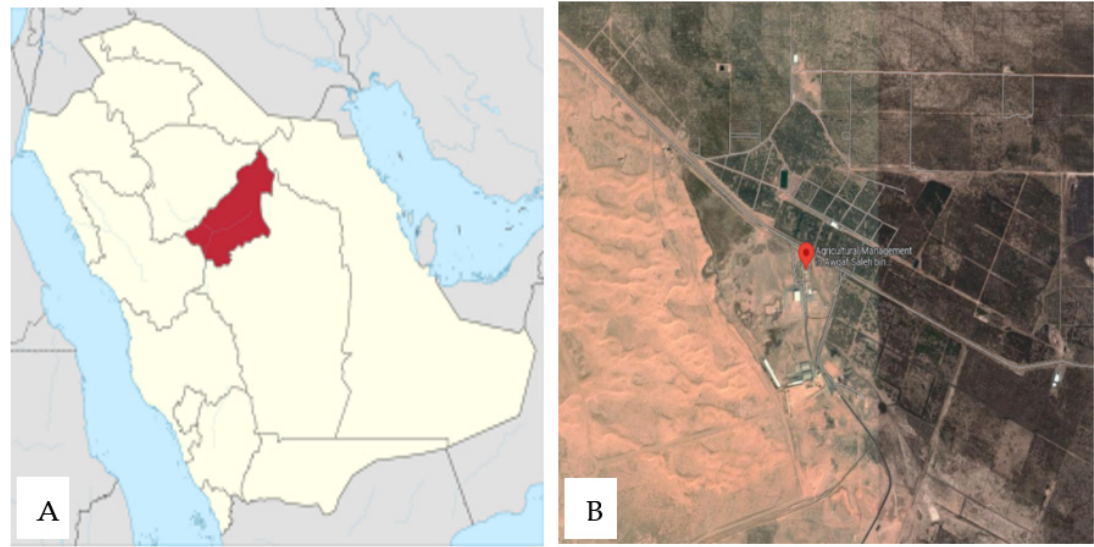
Figure 4. ( A ) The location map of the Al ‐ Qassim region and ( B ) The location map of the experimental site.